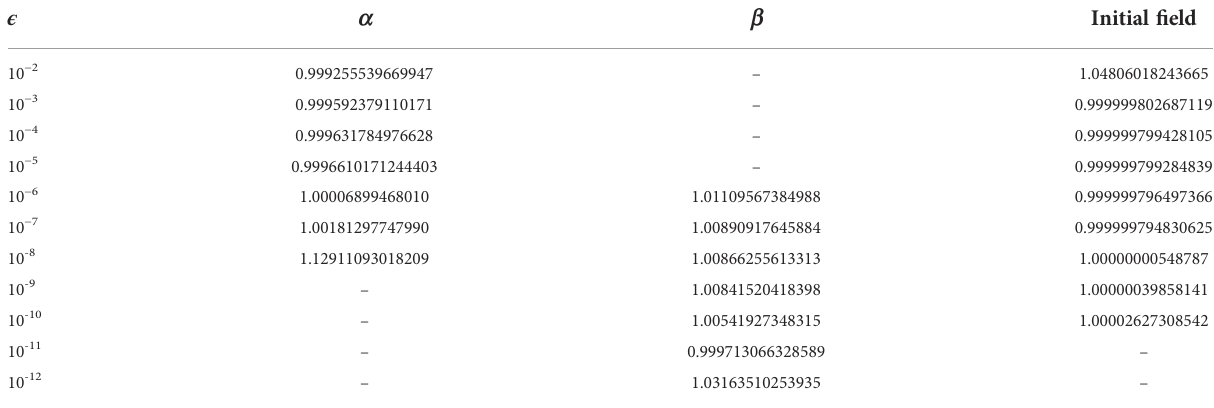
TABLE 3 The correctness test of the TLM with respect to a , b , and initial fi eld. ϵ a